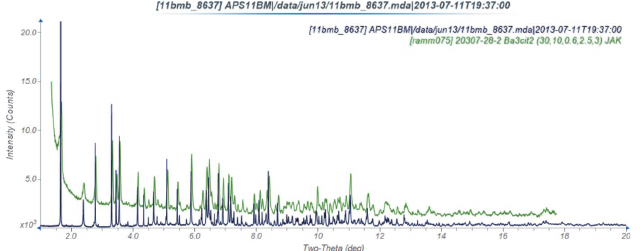
Figure 4 Comparison of the synchrotron (black) and laboratory X-ray powder diffraction patterns of (I). The laboratory pattern (measured using Cu K (cid:2) radiation) was converted to the synchrotron wavelength of 0.413891 A˚ using JADE Pro (MDI,